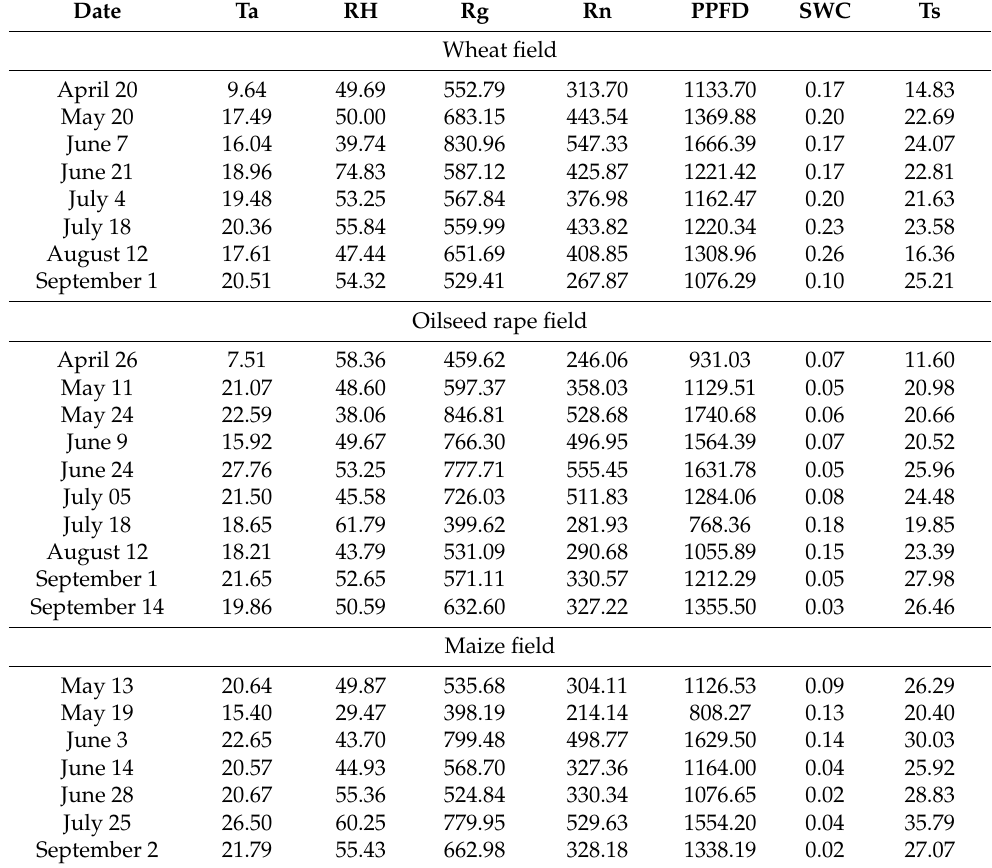
Table 2. Microclimatic conditions during measurements in the studied